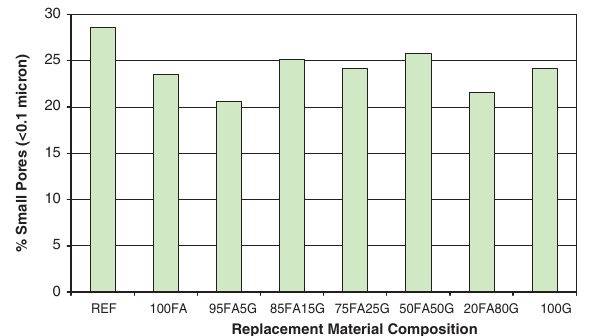
Fig. 12. Influence of simulated FGD on the percentage of small pores ( B 0.1 m) of